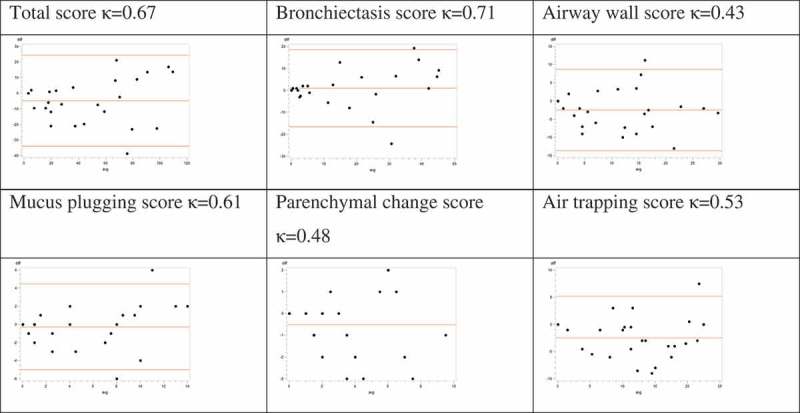
Bland–Altman plots for total score and subdomains assessing systematic bias between scorers in the training CTs done prior to scoring the study cohort.